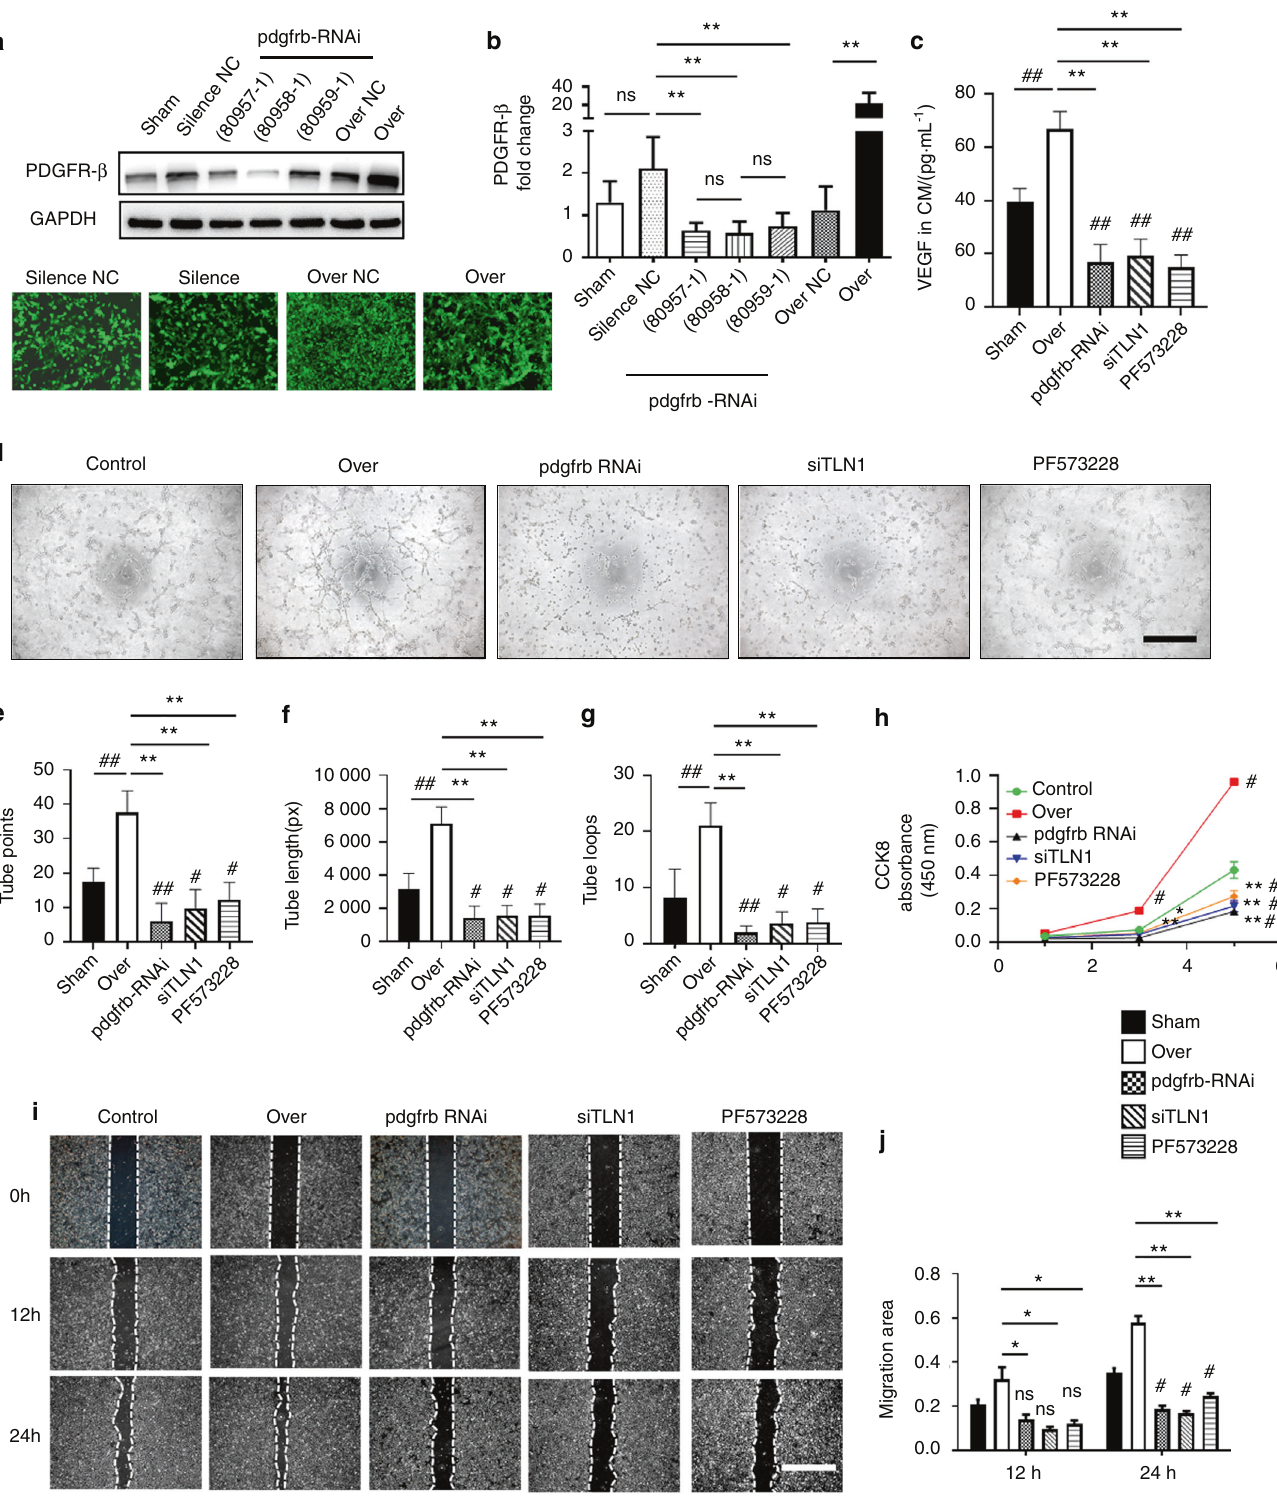
Fig. 6 Endothelial PDGFR- β promotes angiogenesis through the PDGFR- β /Talin1/FAK pathway. The ef fi ciency of lentivirus transfection was veri fi ed using Western blot analysis ( a ) and qRT ‒ PCR ( b ). For pdgfrb silencing, 80958-1 exhibited optimum ef fi ciency and was selected for the following experiments. c ELISA examination of VEGF expression in the CM of BMECs under different conditions. d – g Representative images and quanti fi cation analysis of tube formation in BMECs. Scale bar, 500 µm. h CCK-8 measurement of BMEC proliferation under different conditions. i , j Scratch wound assay showing BMEC motility under different conditions. Scale bar, 200 μ m. Control = CM of BMECs from the normal control group; Over = CM of BMECs transfected with Lv-PDGFR- β ; pdgfrb silencing = CM of BMECs transfected with Lv-si PDGFR- β ; siTLN1 = CM of BMECs transfected with TLN1 siRNA; PF573228 = CM of BMECs treated with PF573228 (FAK inhibitor). * P < 0.05 and ** P < 0.01 compared to the over group. # P < .05 and ## P < .01 compared to the control